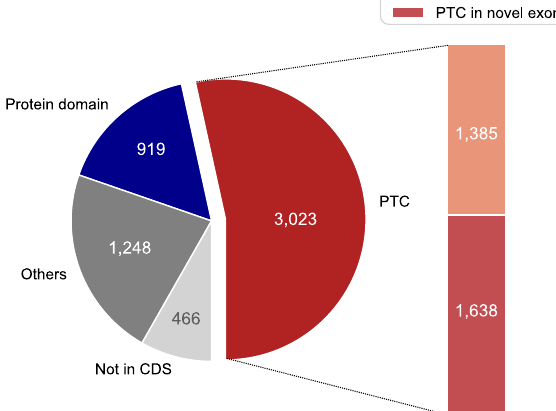
Fig. 4 Effect of SCM-induced length alterations on the transcripts and the proteins. The left pie chart shows the functional consequences of the 5656 SCMs identi fi ed. “ PTC ” indicates those that seem to induce NMD by creating PTC. These are further divided into those that create PTCs by frameshifts and those that introduce in-frame PTC in the extended part of the affected exon. “ Protein domain ” indicates that the coding alteration by the SCM disrupts the protein domain structure. “ Not in CDS ” indicates that the SCMs are located outside of the protein-coding regions. “ Others ” indicates SCMs that do not seem to trigger NMD or those that reside outside of the protein domain structures.